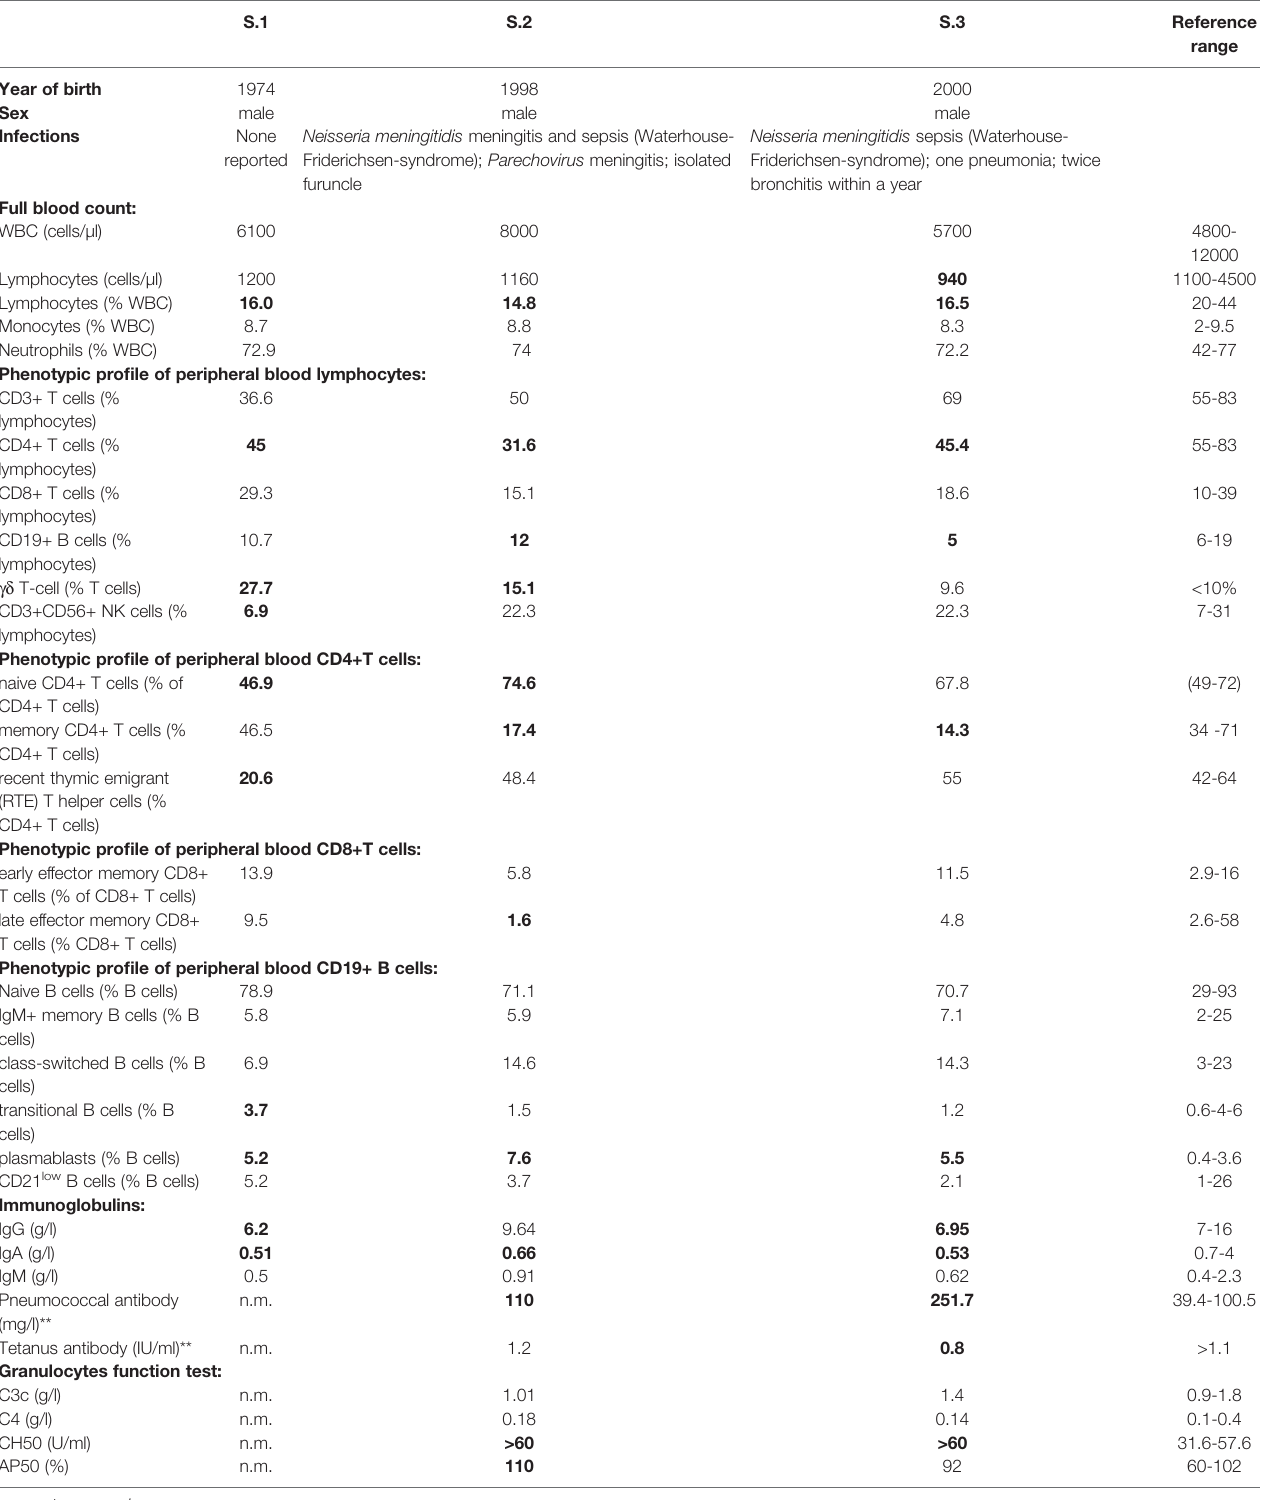
TABLE 1 | Clinical and immunological characteristics of studied subjects with NF- k B1 LOF variant. S.1 S.2 S.3 Reference